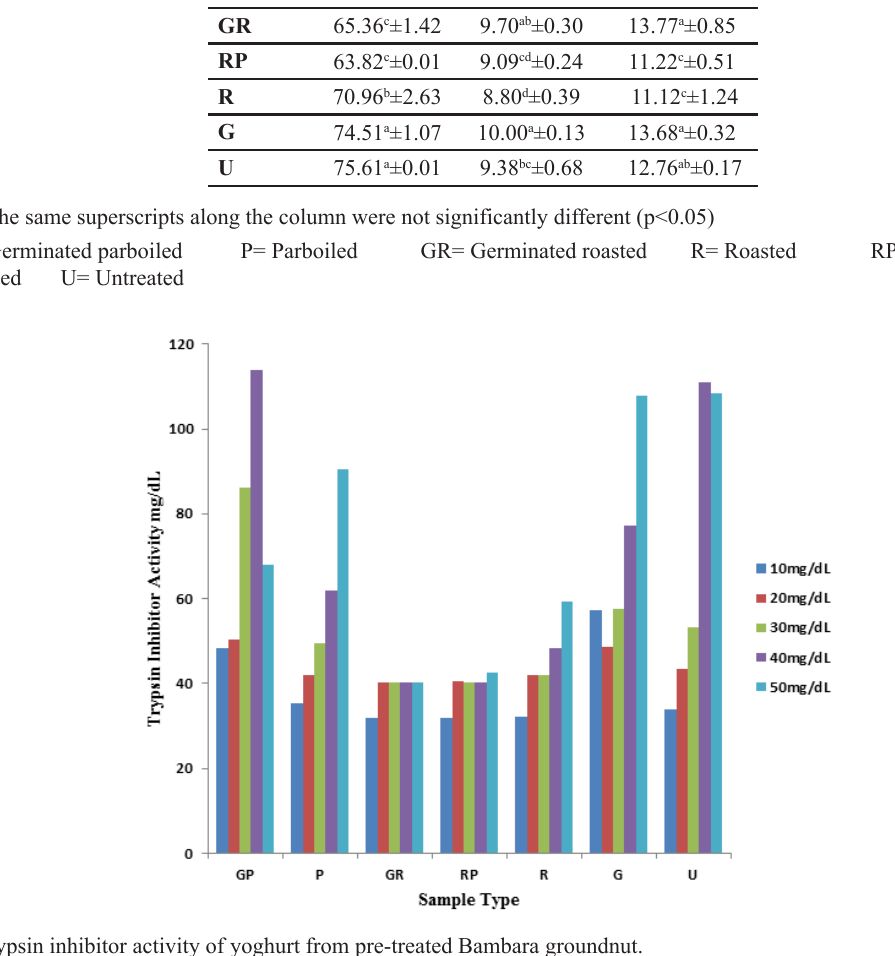
Figure 2: Trypsin inhibitor activity of yoghurt from pre-treated Bambara groundnut.